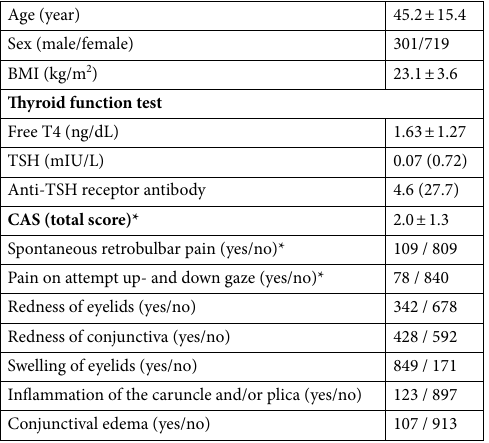
Table 1. Baseline characteristics. Data are expressed as mean ± SD or median (interquartile range). BMI body mass index, T4 thyroxine, TSH thyrotropin, CAS clinical activity score. *918 patients were included in analysis due to lack of record about orbital pain.